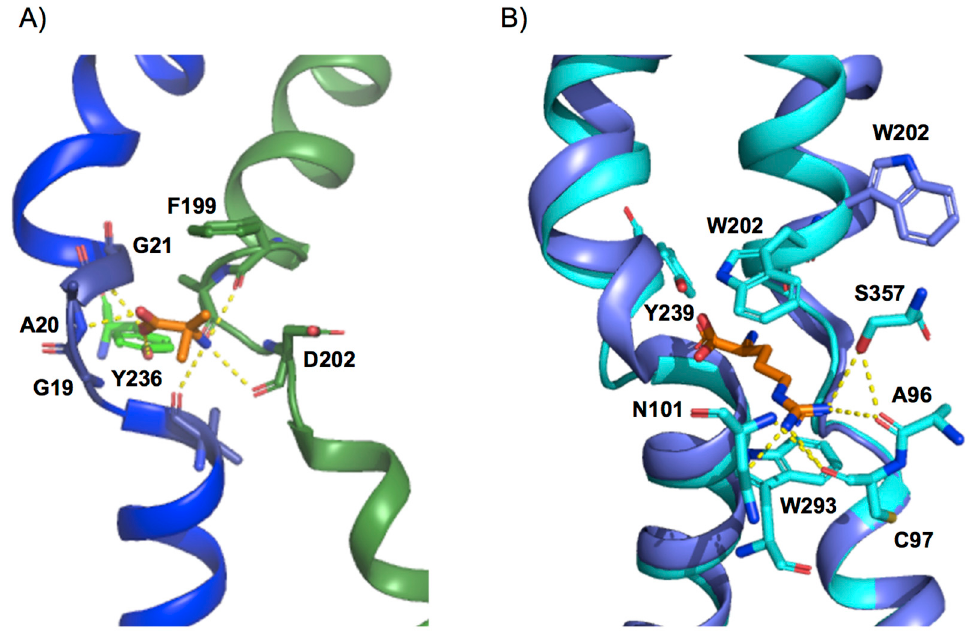
Figure 3. Substrate-binding site design in APC transporters. ( A ) View of the bacterial alanine–serine–cysteine exchanger substrate-binding site (PDB ID 6F2W). Distances between atoms of the substrate (AIB, orange) and BasC residues compatible with H bonds are indicated (dashed lines). F199 acts as the external thin gate, sealing the binding site from the extracellular side. ( B ) Superimposition of AdiC outward-facing open apo (PDB ID 3J4I) and outward-facing arginine-bound and occluded (PDB ID 3L1L). Distances between atoms of the substrate side chain (L-arginine, orange) and AdiC residues compatible with H bonds are indicated (dashed lines). Tyr 239 (equivalent to Tyr 236 in BasC) is also depicted. Trp 202, which acts as the external thin gate, tilts away from the binding site in the outward-facing open conformation, allowing substrate release. Protein representations were created with PyMOL software (The PyMOL Molecular Graphics System, Version 2.3, Schrodinger, LLC. 2010).